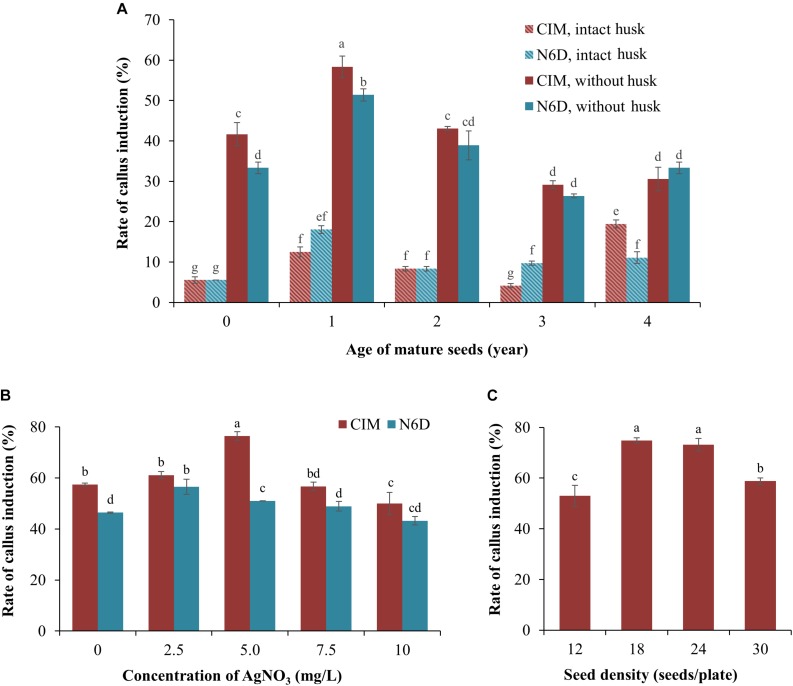
Improvement of callus induction from mature Setaria viridis seeds. (A) The effect of media and seed age on the rate of callus induction. Two medium compositions (CIM and N6D media) were used to test the rate of callus induction from intact and de-husked mature seeds stored at 4°C for different periods of time, ranging from freshly harvested seeds (0 year-old) to seeds that had been stored at 4°C for 4 years. (B) Effect of silver nitrate on the prevention of callus necrosis. CIM and N6D media supplemented with 0.0 to 10 mg/L AgNO3 was assessed to determine the impact of AgNO3 addition on callus quality. (C) The effect of different seed densities on the rate of callus induction was also assessed. The results of statistical analysis are presented as letters on the histograms. The same letter indicates a non-statistically significant difference (p > 0.05), whereas a different letter indicates a statistically significant difference (p < 0.05).